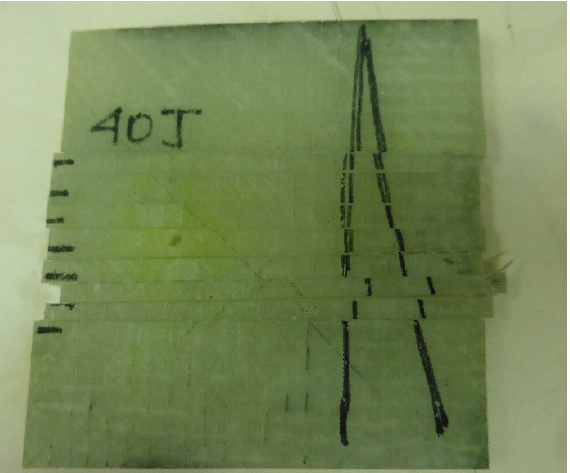
Figure 3. Section cuts for selection of exposure to fluorescent light for a specimen extracted from a panel impacted at 40 Joules.